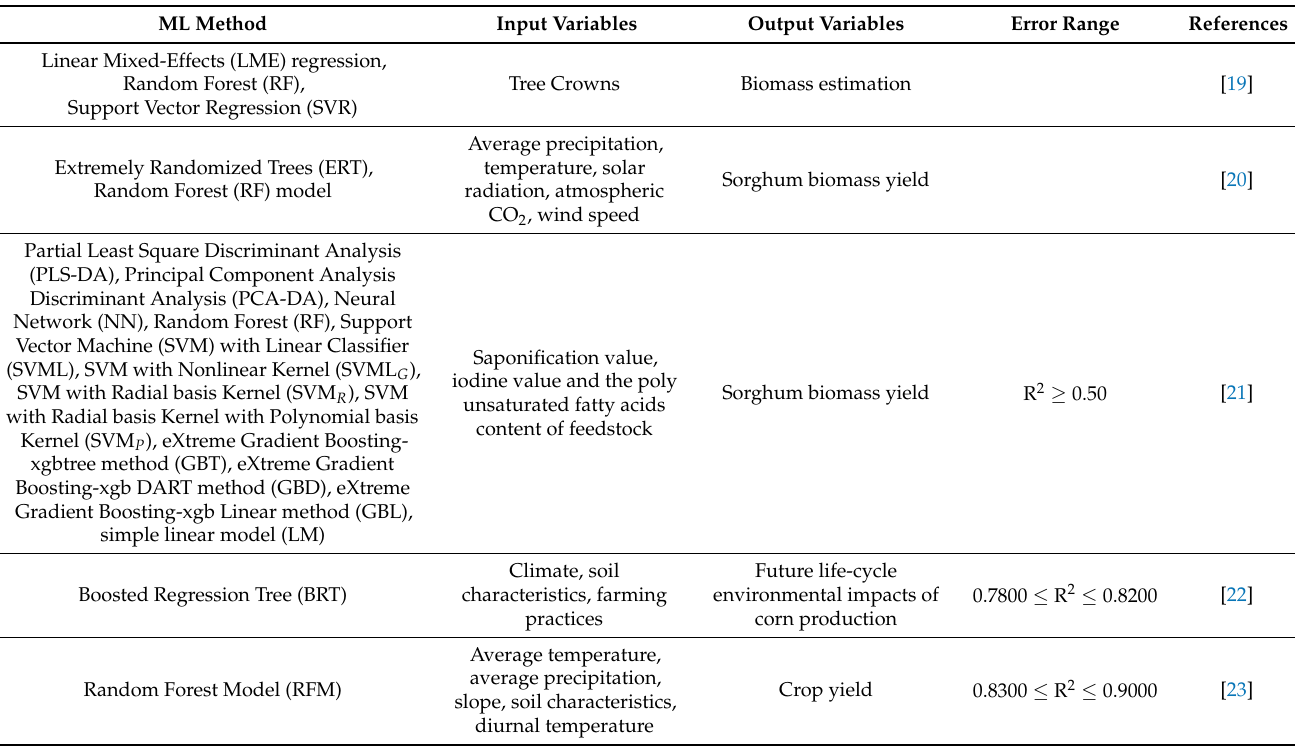
Table 2. Summary of ML applications in the soil